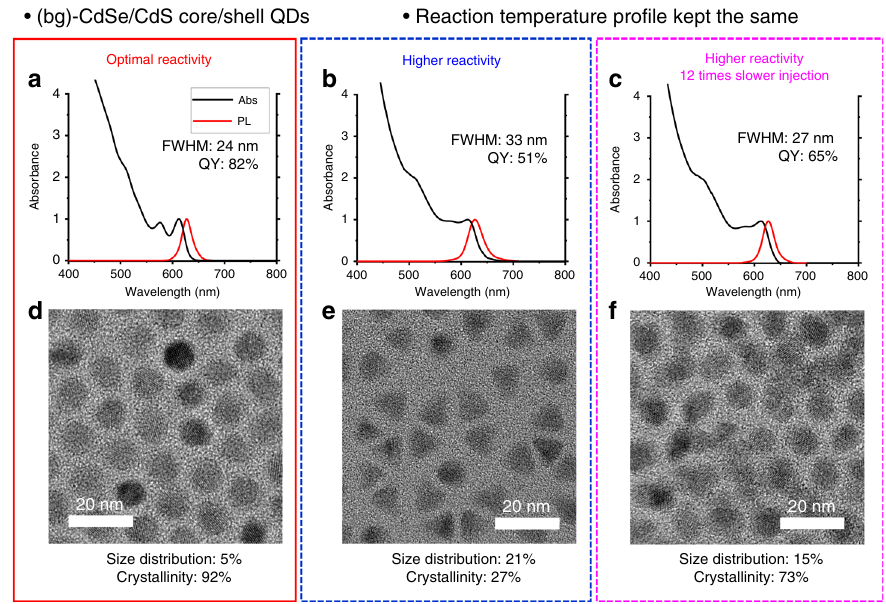
Fig. 3 Impact of precursor reactivity to the optical and structural quality of QDs. The (bg)-CdSe/CdS QDs grown at the same reaction temperature by infusing ( a – d ) [BBN-SH:4-CF 3 Py] for 2 h, ( b , e ) [BBN-SH:DMAP] for 2 h, or ( c – f ) [BBN-SH:DMAP] for 24 h. a – c Absorbance and PL spectra of (bg)-CdSe/ CdS QDs. d – f TEM images of (bg)-CdSe/CdS QDs (scale bar: 20 nm). Higher reactivity of the precursor yields lower QY, inferior crystallinity, broader FWHM, and uncontrolled growth. A signi fi cant reduction in the infusion rate partially improves the quality of the produced